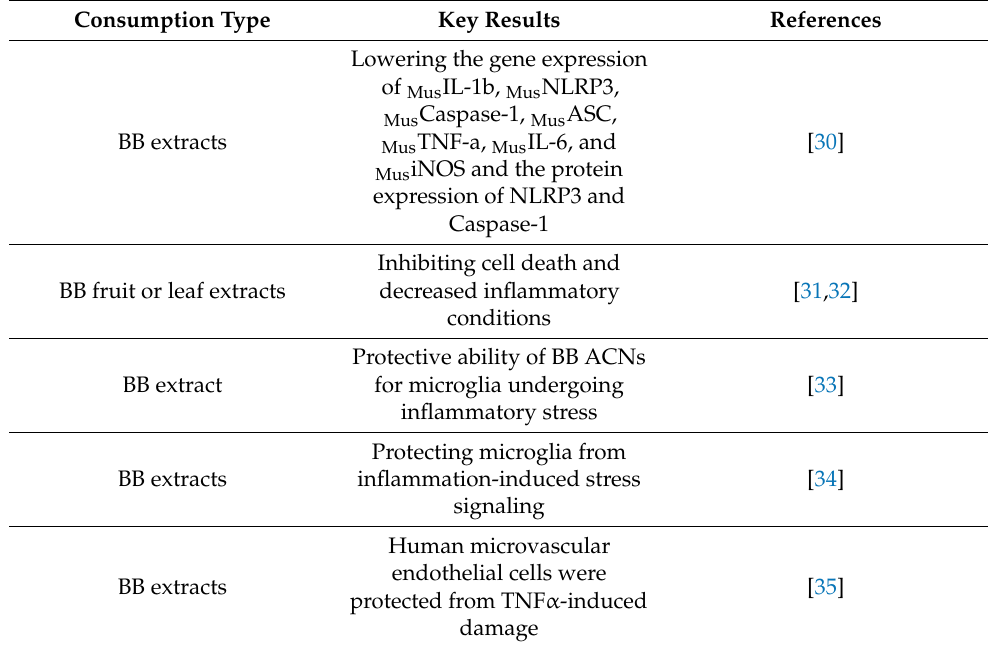
Table 1. Potential in vitro effects of Blueberries (BBs) on brain health